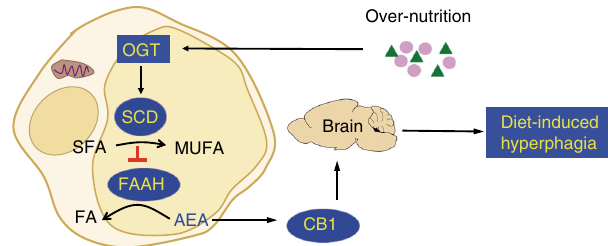
Fig. 6 A working model for appetite regulation in obesity. The fat-sensing adipose tissue-to-brain axis induces hyperphagia when palatable foods are available. This appetite-inducing axis in adipose tissue is activated by the fat-sensing module OGT, which trans-activates expression of the lipid desaturation module SCD. SCD facilitates the accumulation of the appetite- inducing module AEA, which activates peripheral CB1 signaling to